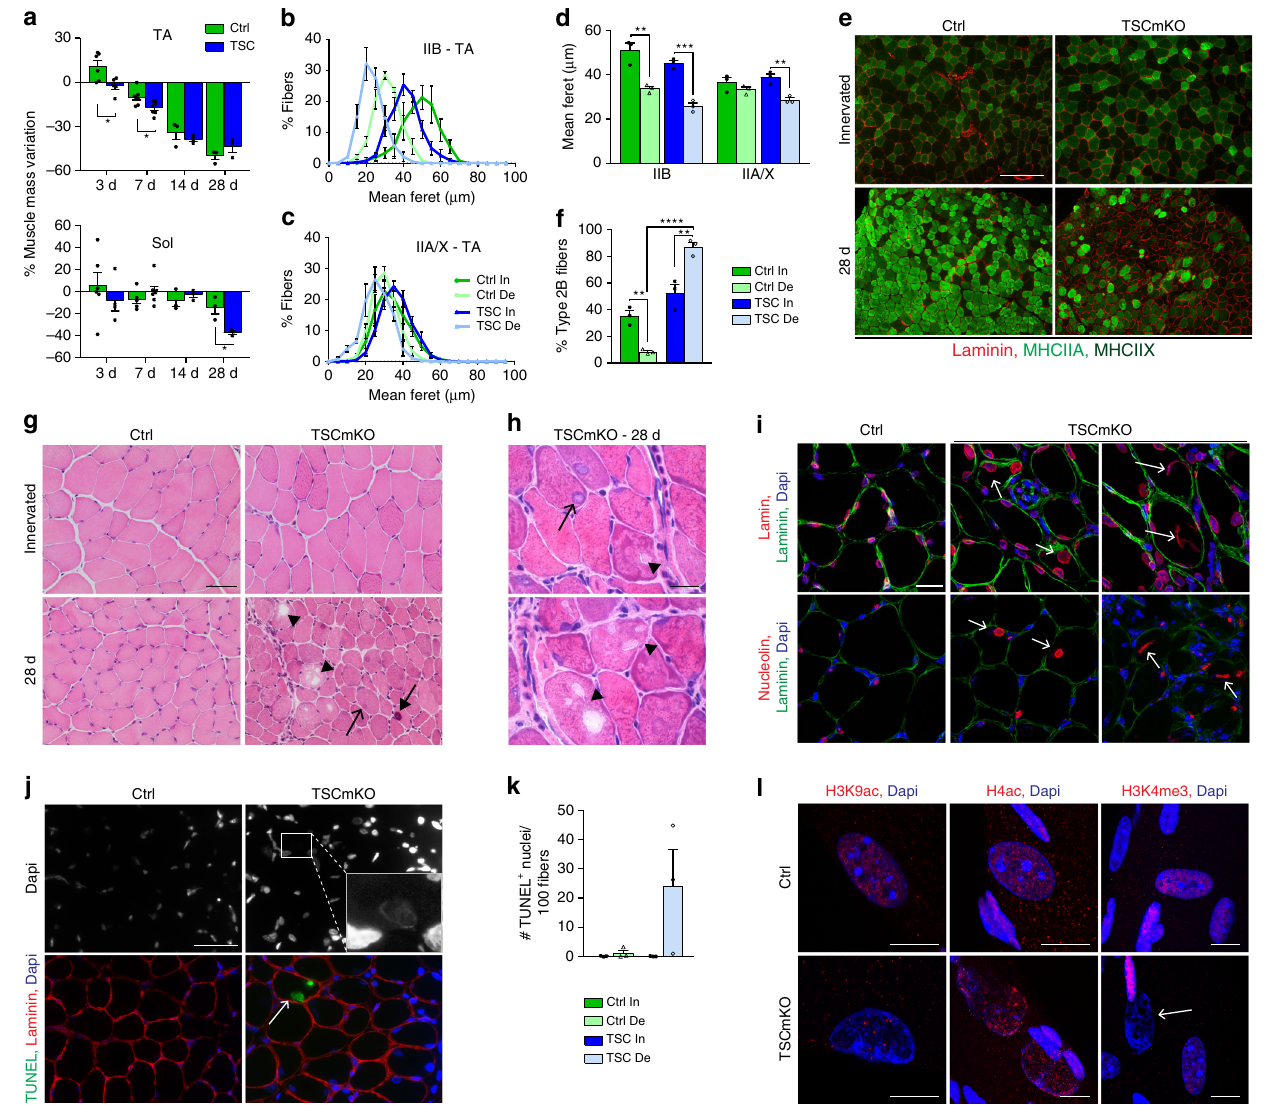
Fig. 2 Sustained mTORC1 activation impairs muscle response to denervation. a Mass variation for TA and soleus muscles in control (Ctrl) and TSCmKO (TSC) mice, after 3, 7, 14 and 28 days of denervation, compared to innervated muscle. n = 6 Ctrl, 5/4 TSCmKO (3d TA/Sol), 7/5 (7d TA/Sol) and 3 (14 and 28d) mice per genotype. b , c Fiber size distribution for type IIB ( b ) and IIA/X ( c ) fi bers in TA innervated (In) and denervated (De, 28d) muscles from control and TSCmKO mice. n = 3. d Minimum mean fi ber feret in TA innervated and denervated (28d) muscles from control and TSCmKO mice, distinguishing type IIB and IIA/X fi bers. n = 3. e , f Immunostaining of TA control and TSCmKO muscles for MHCIIA/X (green) and laminin (red). Scale bar, 200 µ m. Quanti fi cation ( f ) gives the proportion of type IIB fi bers in TA innervated and denervated (28d) muscles. n = 3. g , h HE coloration of TA control and TSCmKO innervated and denervated (28d) muscles (6 independent muscles per group). Open arrows, arrows and arrowheads point to swollen nuclei, basophilic aggregates and vacuoles, respectively. Scale bar, 50 ( g ) and 10 ( h ) µ m. i Confocal pictures of lamin (red, top) and nucleolin (red, bottom), laminin (green) and Dapi (blue) in control and TSCmKO denervated (14 and 28d) muscles (3 independent muscles per group). Arrows indicate giant, swollen myonuclei. Scale bar, 20 µ m. j , k TUNEL staining in control and TSCmKO muscles after 28 days of denervation. The arrow points to a positive, swollen myonucleus, as shown in the inset with increased brightness. Scale bar, 50 µ m. Quanti fi cation in ( k ) gives the number of TUNEL-positive nuclei detected per 100 muscle fi bers in control and TSCmKO innervated muscles, and after 28 days of denervation. n = 3 mice/group. l Confocal pictures of acetylated histones H3 (Lys9; H3K9ac) and H4 (H4ac) and of trimethylated H3 (Lys4, H3K4me3) in denervated (14d) control and TSCmKO muscles (4 independent muscles per group). The arrow indicates a swollen myonucleus. Scale bar, 10 µ m. Values are mean ± s.e.m.; two-tailed unpaired Student ’ s t- test ( a ) or two-way ANOVA with Tukey ’ s post-hoc test ( d , f ), * p < 0.05, ** p < 0.01, *** p < 0.001. Source Data are provided in the Source Data